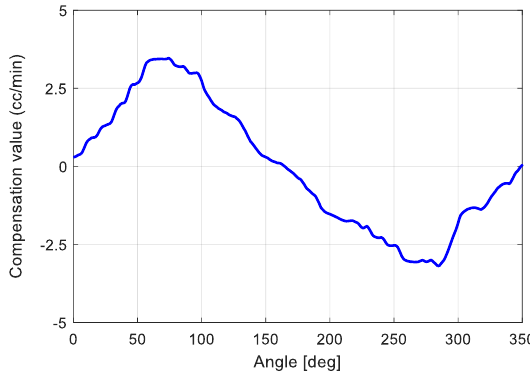
Figure 10. Rotational angle of the motor-dependent compensation.